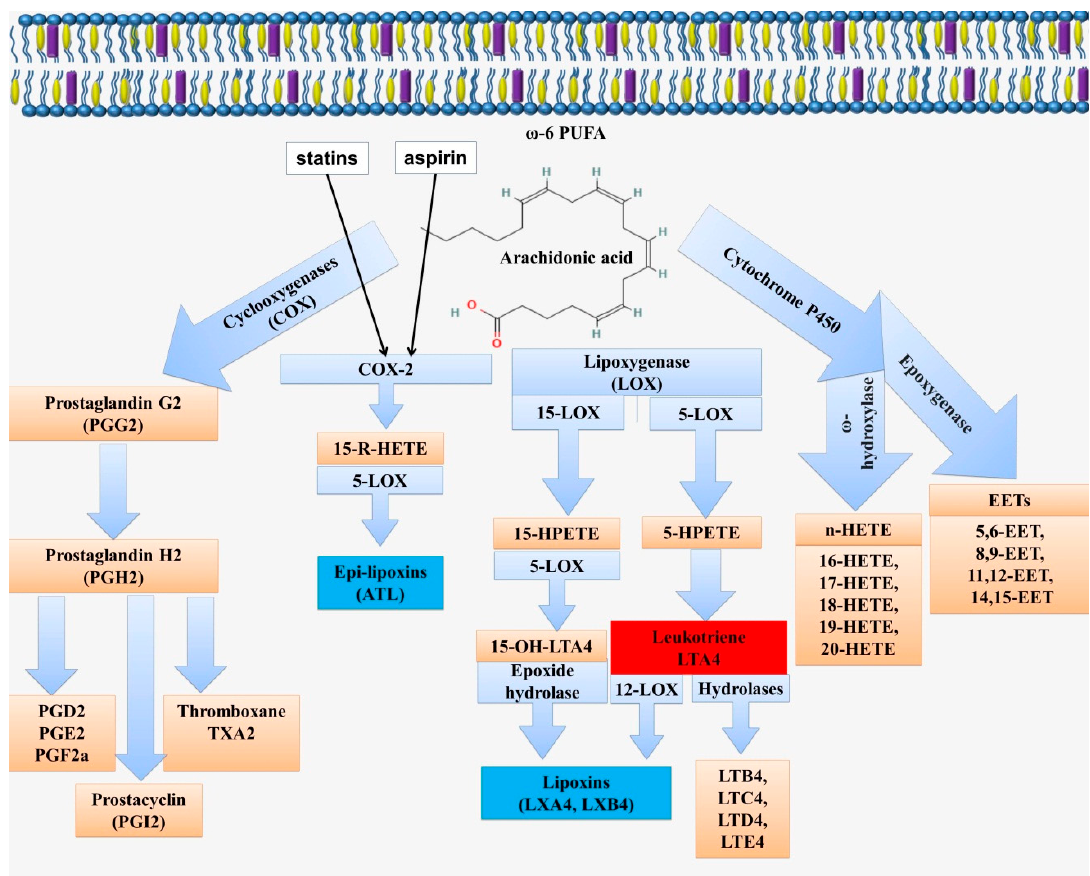
Figure 3. Scheme of biosynthesis of lipid mediators from arachidonic acid. Arachidonic acid can be metabolized via the cyclooxygenase (COX), lipoxygenase (LOX), or cytochrome P 450 pathways (CYP). Enzymatic conversion through the COX pathway leads to the formation of prostaglandins (PG). The LOX pathway is associated with the formation of lipoxins (LX) and leukotrienes (LT) via 5-LOX, 12-LOX, and 15-LOX. This pathway includes the formation of the intermediate metabolites 5-/15-hydroperoxyeicosatetraenoic acid (5-/15-HpETE) and 5-/15-hydroxyeicosatetraenoic acid (5-/15-HETE). The ω -hydroxylase activity of CYP enzymes leads to the formation of hydroxyeicosatetraenoic acids (16-, 17-, 18-, 19-, and 20-HETE). The epoxygenase activity of CYP enzymes is associated with the formation of arachidonic acid epoxides or epoxyeicosatrienoic acids (EETs; 5,6-EET, 8,9-EET, 11,12-EET and 14,15-EET), known as endothelial-derived hyperpolarizing factors.